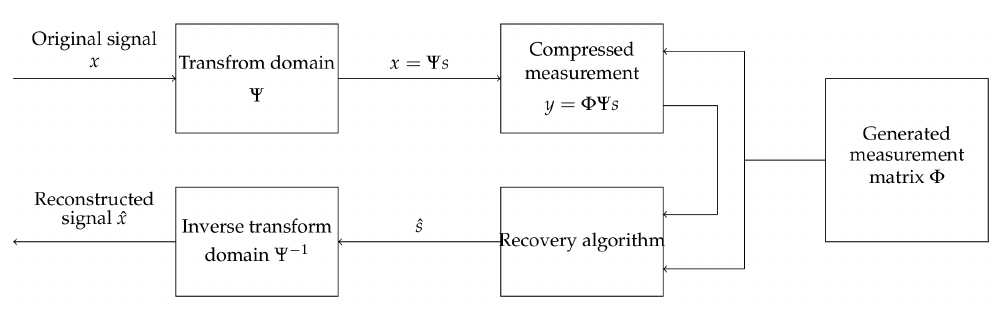
Figure 1. The frame of